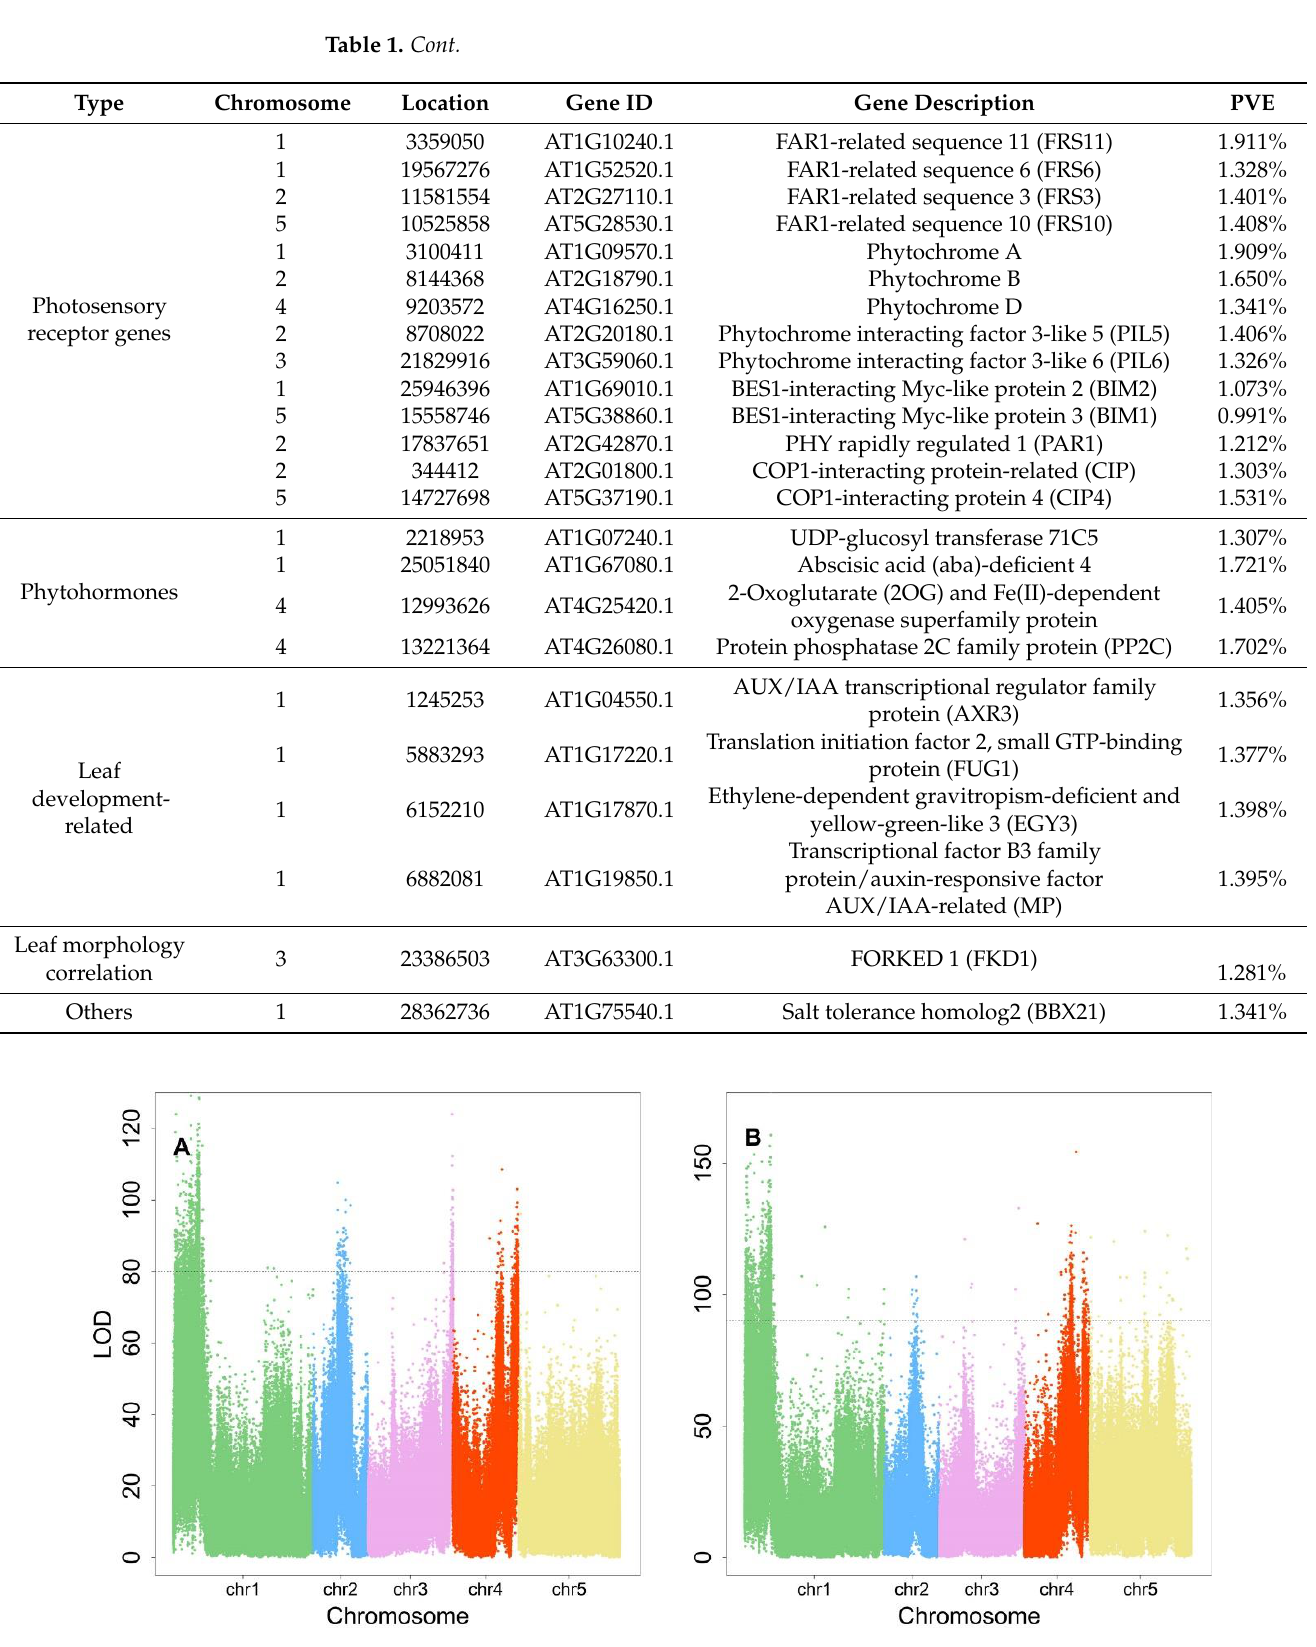
Figure 4. Manhattan plot of association results with shade avoidance syndrome. (A) and (B) are association results for the allometry association results for leaf length – leaf area and petiole length – leaf length, respectively. The dashed horizontal line represents the LOD threshold at the significance level of 0.05.